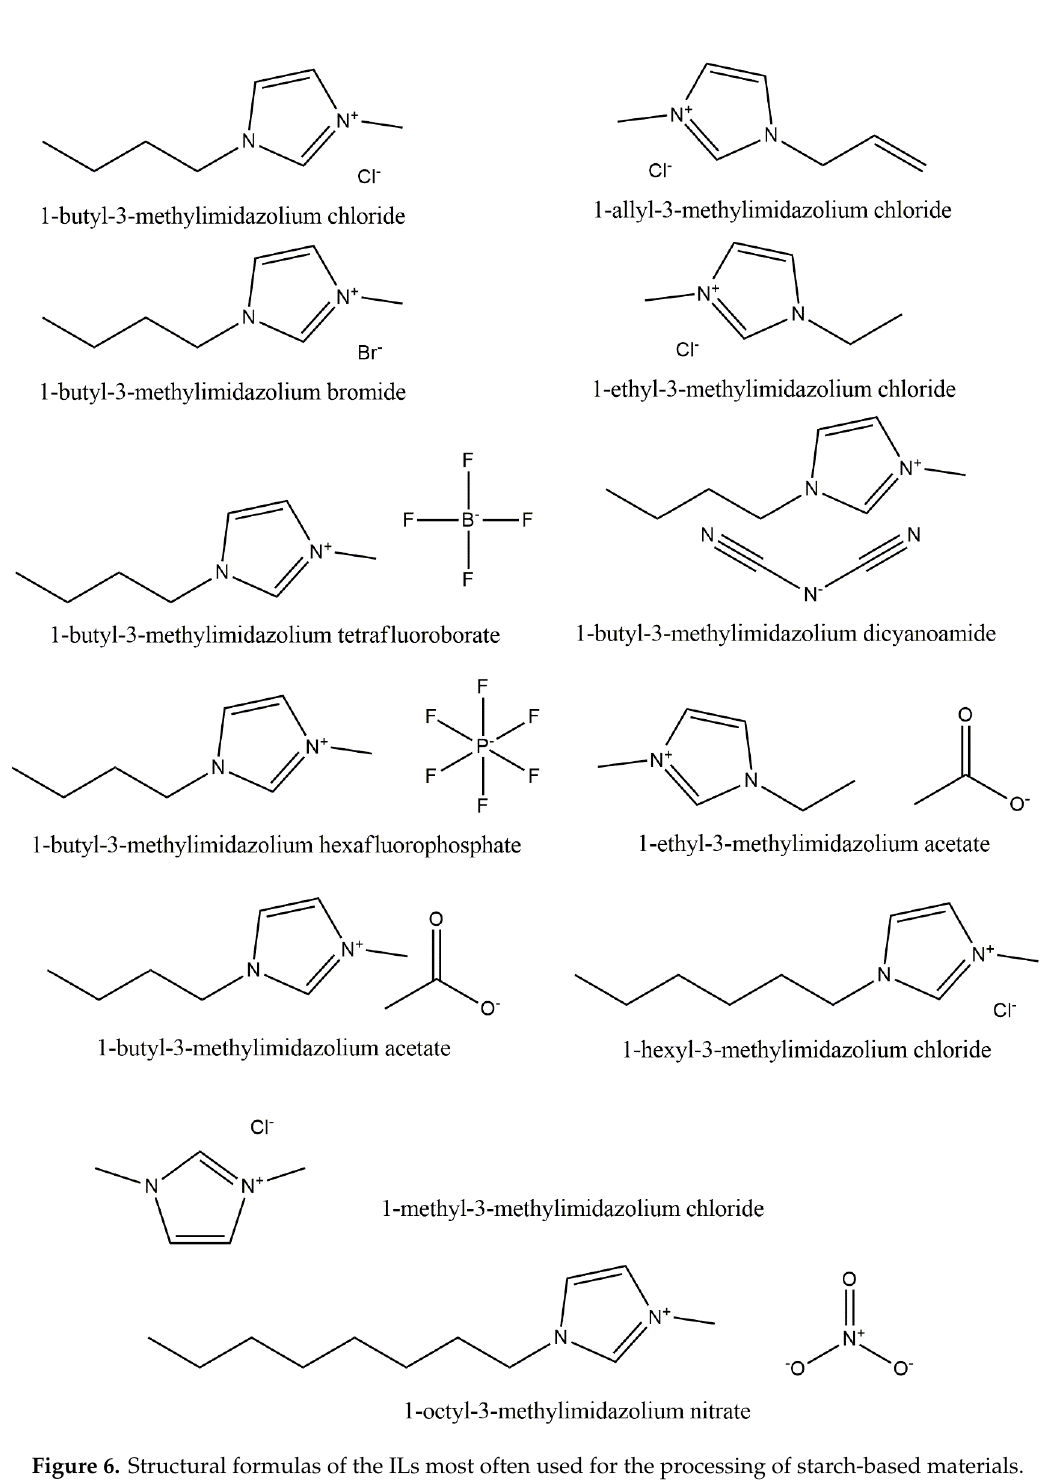
Figure 6. Structural formulas of the ILs most often used for the processing of starch-based